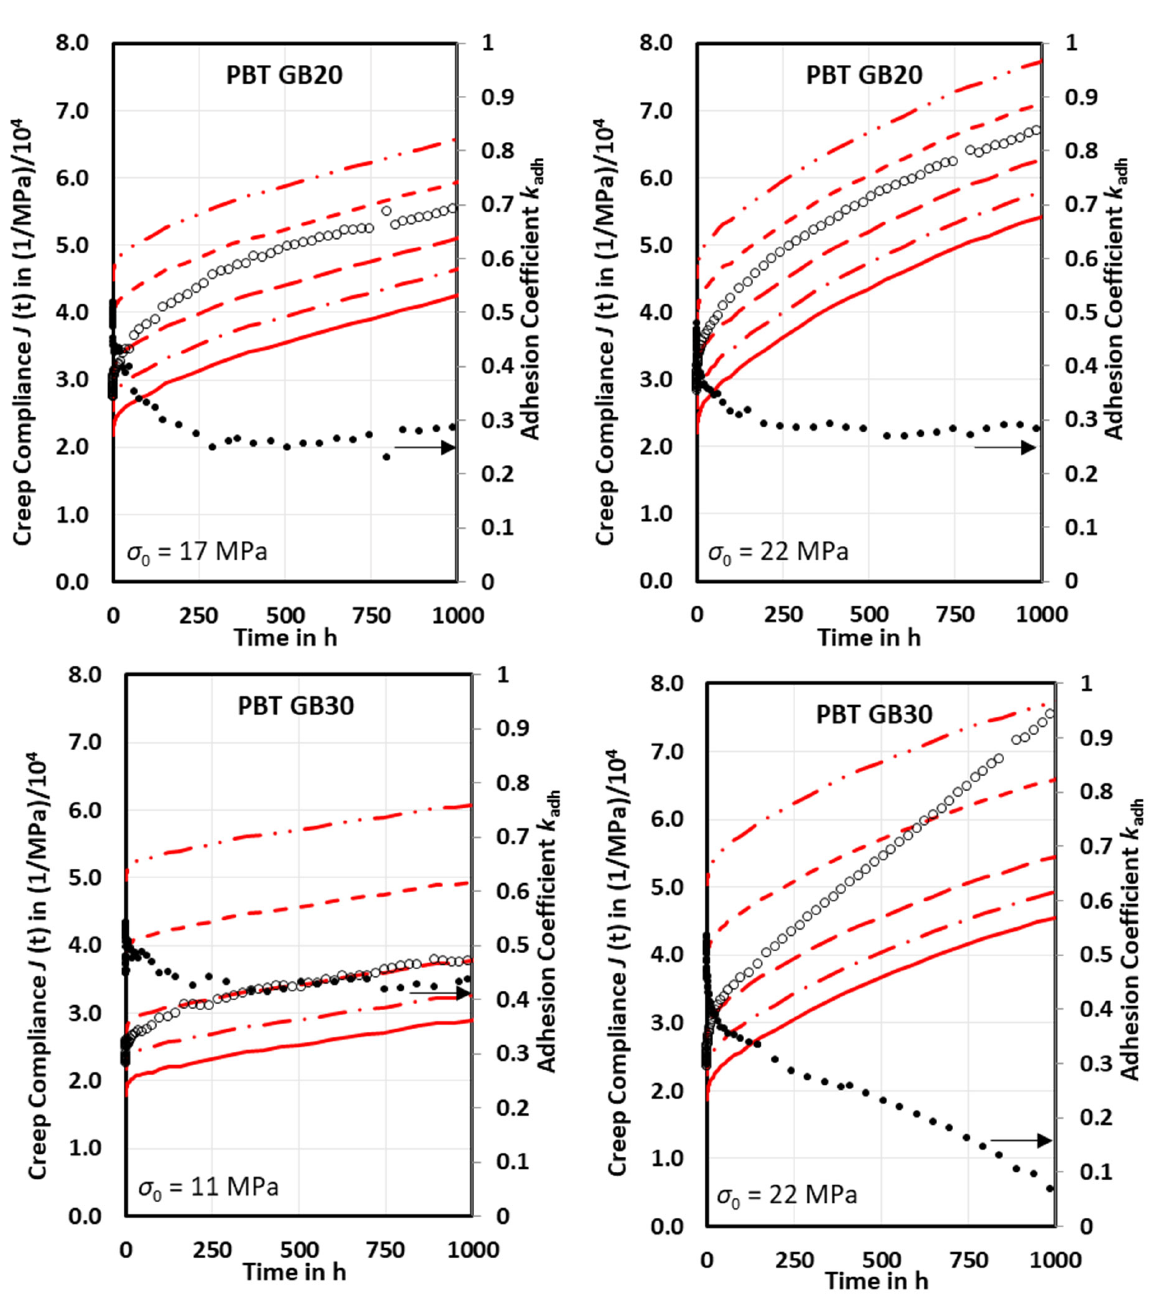
Figure 3. Comparison of measured creep compliances (o) of PBT GB20 and PBT GB30 to calcu‑ lated creep compliances with adhesion coefficients k adh = 0, 0.2, 0.4, 0.6, and 1 (lines from top to bottom) for various initial stresses; point by point evaluated adhesion coefficients ( • ) exhibit clearly time